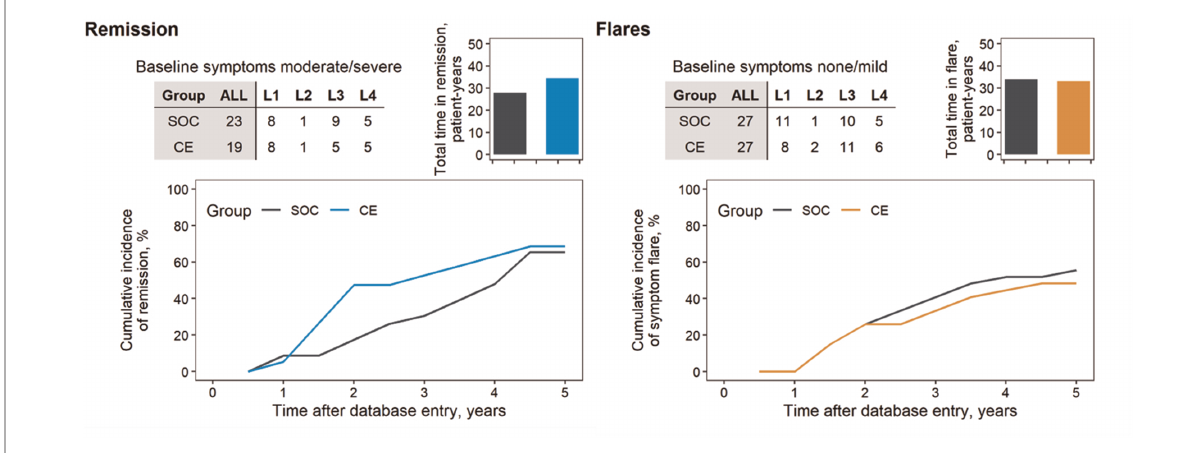
FIGURE 3 Cumulative incidence of remission and fl ares. Patients ’ remission (top) and fl are (bottom) analyses. Patients were divided by CDAI at baseline in moderate/severe symptoms at baseline for analysis of remission outcomes (top) and those with no or mild symptoms for analysis of fl ares (bottom). Analyses were not strati fi ed per disease location because of the limited number of patients (tables, inset). Shaded columns indicate the total in each group in the analysis — four patients from the CE group due to missing CDAI score. Remission was de fi ned as patients ’ experiencing at least two consecutive intervals of no symptoms (CDAI score<150). Flare was de fi ned as the transition from a period of at least two consecutive intervals of no or mild symptoms (CDAI<220) to at least one interval of moderate (CDAI score ≥ 220) or severe (CDAI score ≥